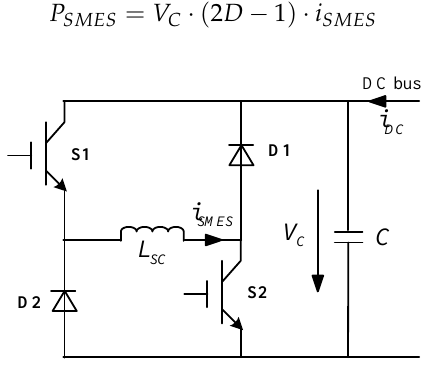
Figure 4. Schematic structure diagram of the bi-directional DC/DC converter for a superconducting magnet.